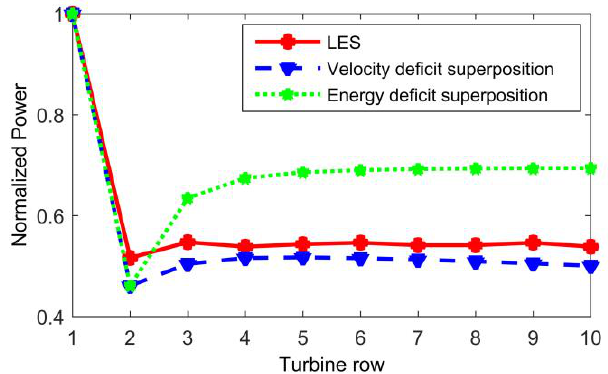
Figure 6. Comparison of the wind-farm power output for 𝜃 𝑤𝑖𝑛𝑑 = 270° obtained using LES as well as the new analytical model with both energy and velocity deficit superpositions.